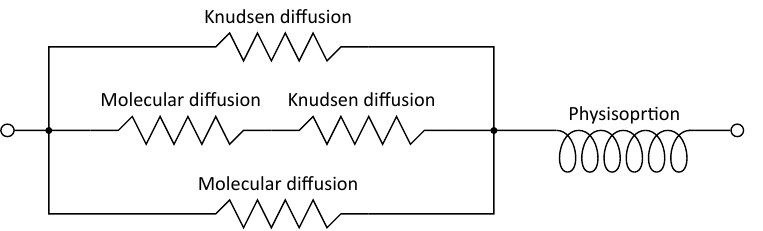
Figure 10. Electrical analogical circuit for the diffusion coefficient of a thick structure including physiportion. The resistor circuit part is adapted from